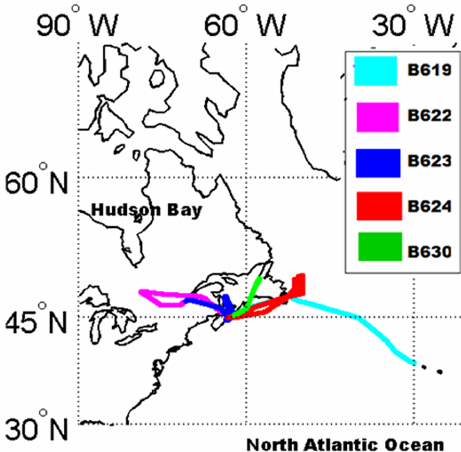
Figure 2. FAAM146 flight tracks during July 2011. The different colours are the tracks of each different flight: during B623 and B624 fire plumes were observed, during B619 and B630 background air was measured, and during B622 fire plume and background air were detected.